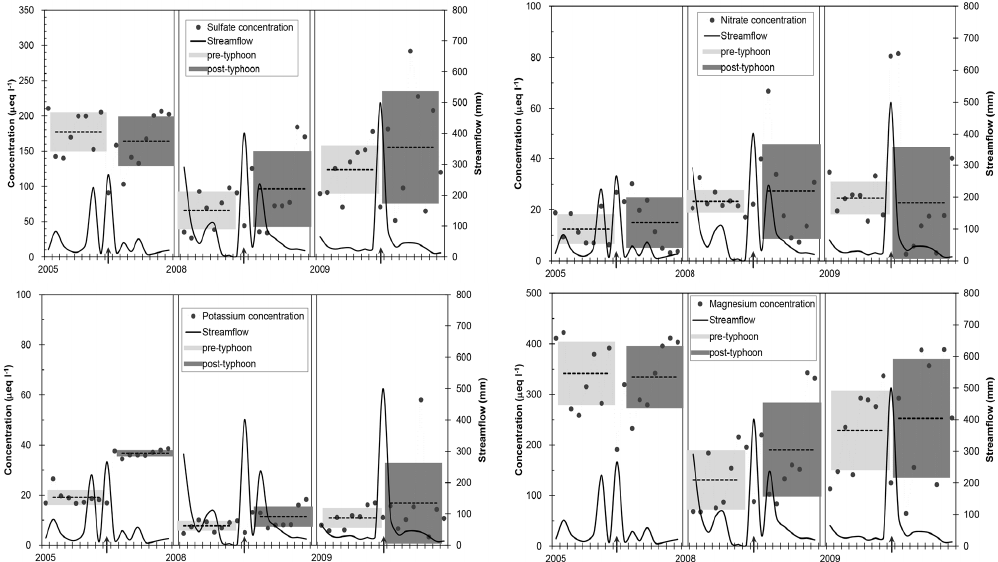
Fig. 4. Fig. 4. Weekly streamflow and mean streamwater chemistry of the 8 weeks before and 8 weeks after the three typhoons with the highest amount of rainfall between 2005 and 2010 (Matsa in 2005, Sinlaku in 2008 and Morakot in 2009). Each arrow indicates the week of typhoon occurrence. Dash lines and gray rectangles represent the mean and one standard deviation of ion concentration of the 8 weeks before and after